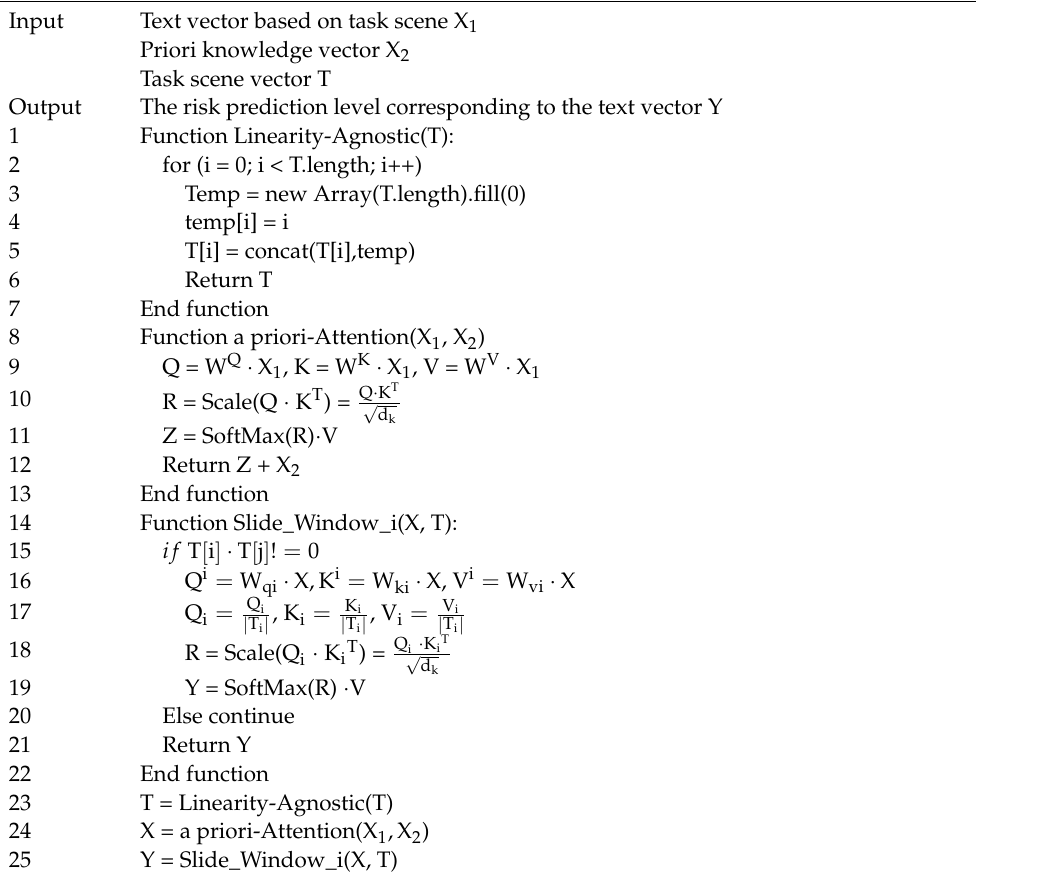
Algorithm 1: Intelligent hierarchical evaluation model of water conservancy project safety